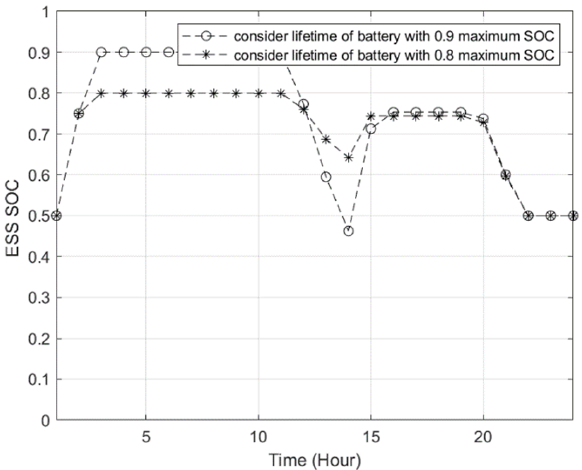
Figure 8. SOC curve of battery banks in Case 1, Case 3.